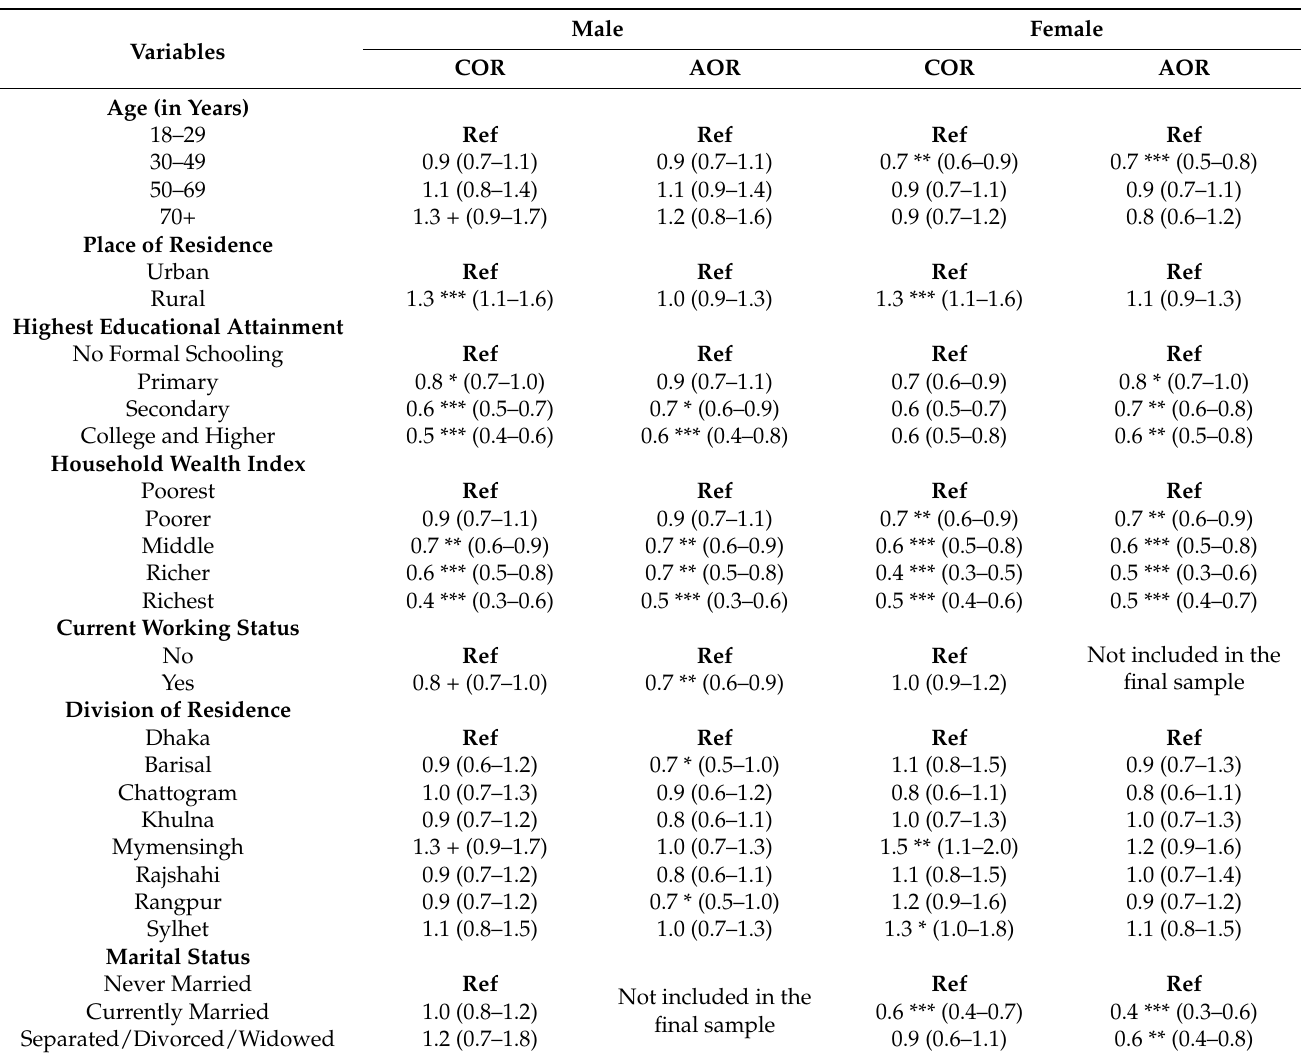
Table 2. Factors associated with underweight among both male and female, BDHS